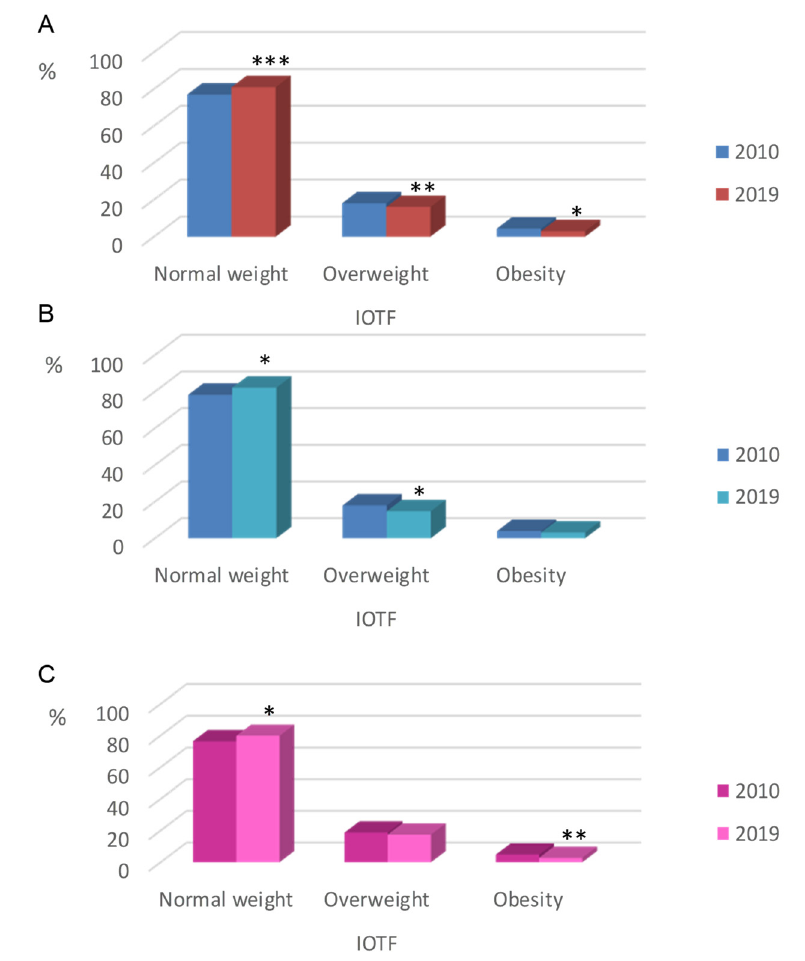
Figure 3. Prevalence of normal weight, overweight and obesity in Spanish children by International Obesity Task Force (IOTF) reference. ( A ) Total population. ( B ) Boys. ( C ) Girls. * p ≤ 0.05 vs. year 2010 (Chi-Square test); ** p ≤ 0.01 vs. year 2010 (Chi-Square test) *** p ≤ 0.001 vs. year 2010 (Chi-Square test).